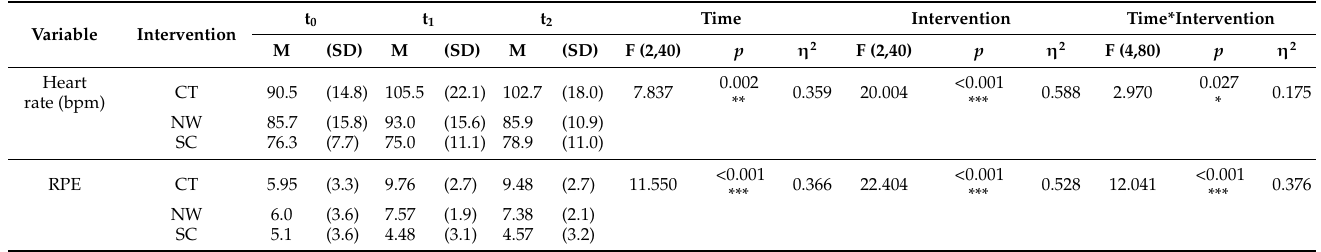
Table 2. Heart rate and RPE results of the three interventions at 3 measurement time